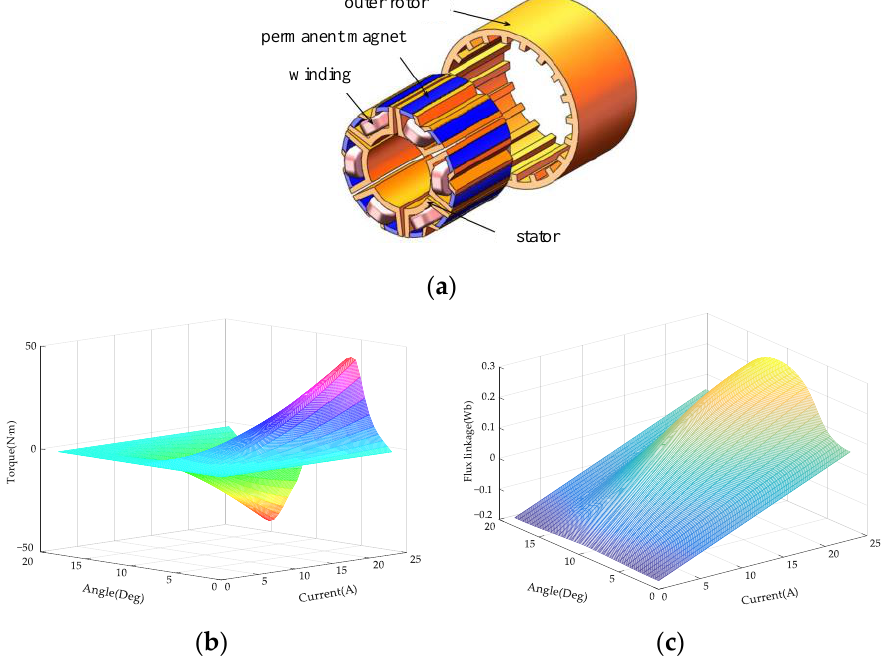
Figure 1. Structure of 6/20 SRM and its simulation results: ( a ) structure; ( b ) torque T ( i , θ ) ; ( c ) flux linkage ϕ ( i , θ ) .